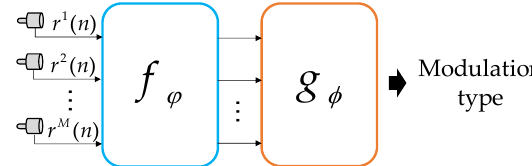
Figure 3. Structure of MHFNet.